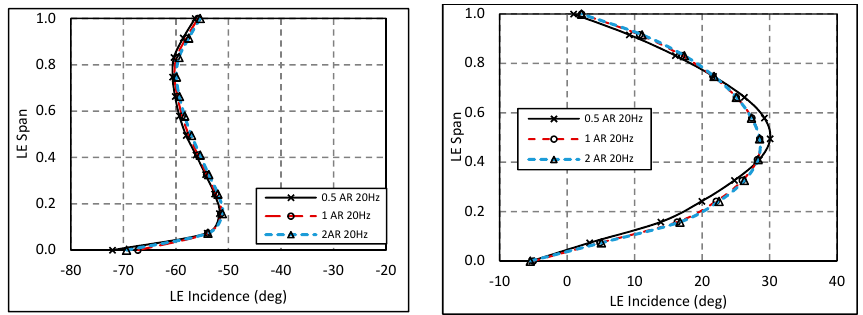
Figure 21. LE incidence at 20 Hz frequency. ( Left ) Minimum incidence running point; ( Right ) Maximum incidence running point.